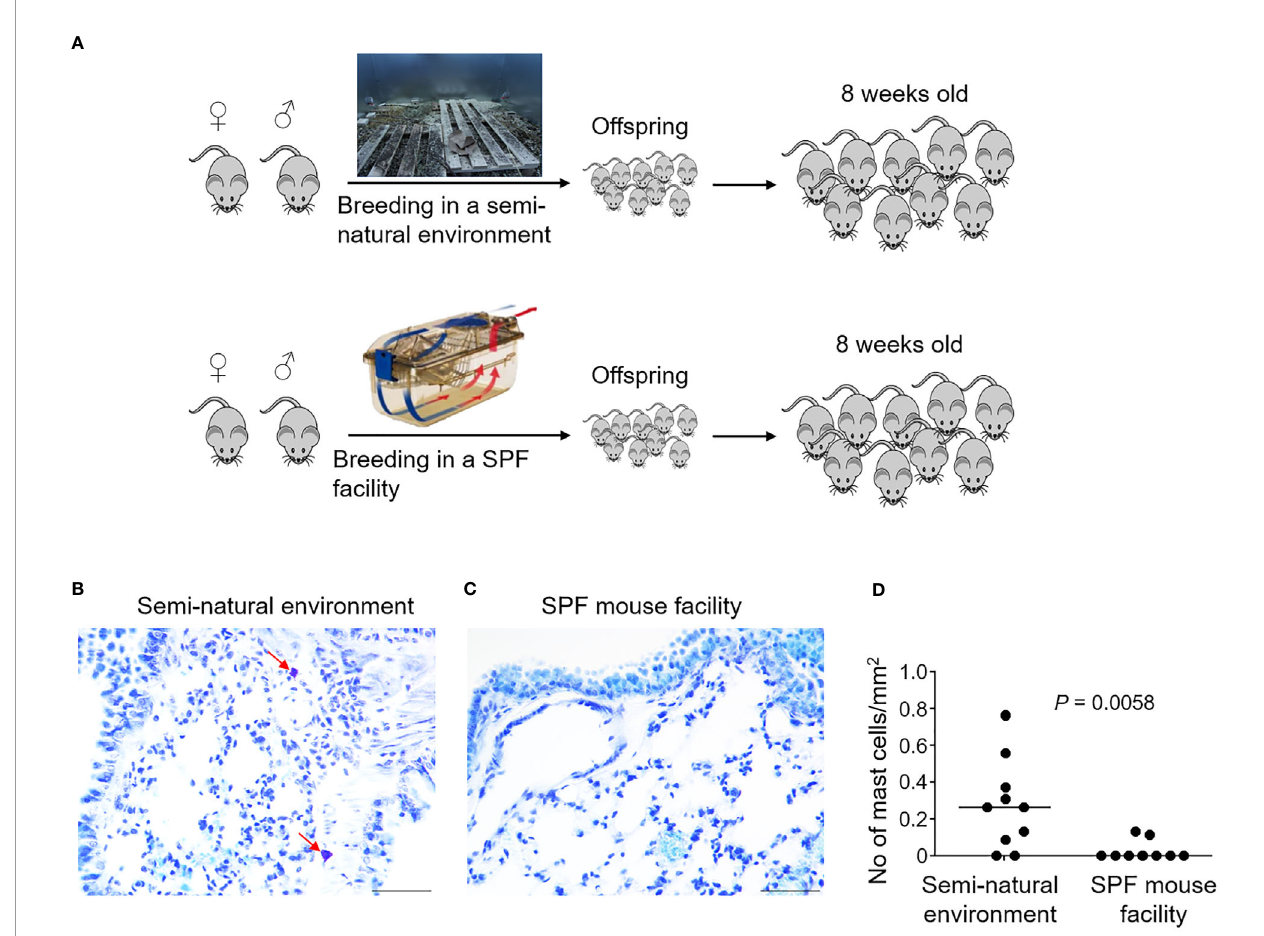
FIGURE 4 | Laboratory mice born and raised in a semi-natural environment develop lung parenchymal mast cells. C57BL/6 laboratory mice were either bred in a purposefully built, closed environment with bedding material from the natural environment at Oslo, Norway, or bred in a conventional speci fi c pathogen-free (SPF) animal facility as indicated (A) . Lung tissues were collected from the mice born and raised in the semi-natural environment [ (B) , n = 10] or the SPF facility [ (C) , n = 10] at 8 weeks old. Lung tissue sections were stained with the mast cell-speci fi c dye toluidine blue. Arrows indicate mast cells which were stained purple. Mast cell density was quanti fi ed by enumerating toluidine blue-positive mast cells per unit area (D) . Each dot represents an individual mouse and horizontal lines indicate the median. Scale bar: 50 m m. One mouse from the SPF group which had an extremely high value was removed as an outlier based on Grubbs ’ test ( P <